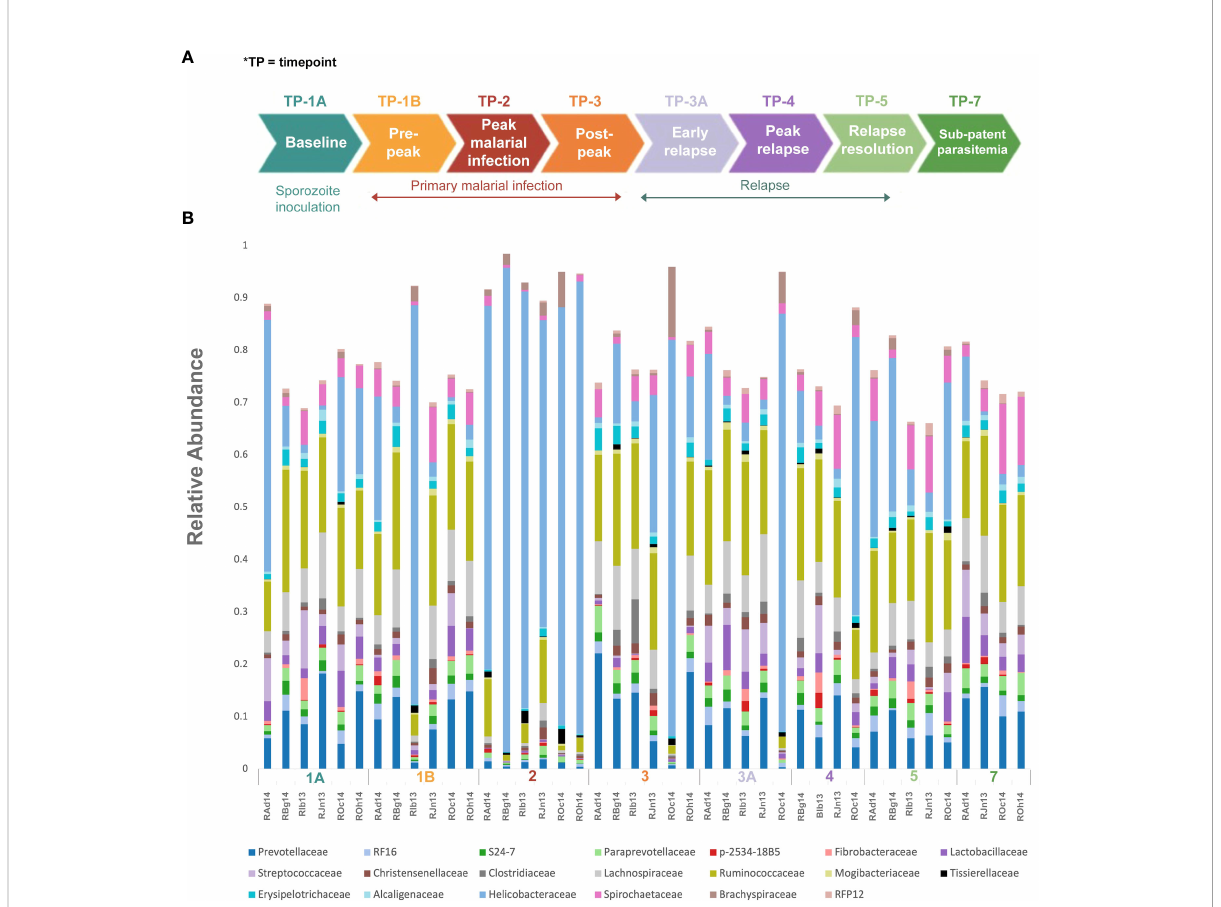
FIGURE 1 Experimental designand gut microbiota compositionof rhesus macaquesduringa longitudinal P. cynomolgi infectionstudy. (A) Experimental schematic for the longitudinal study of P. cynomolgi infection in rhesus macaques. Baseline TP1A for eachmonkey before inoculation of P. cynomolgi M/B sporozoites serves as comparisonfor the rest ofthe experiment. Patent parasitemic periodTP1Brepresents progressive increase of infected RBCs in the bloodfollowed by peak ofinfectionat TP2. Atpost-peak TP3, a decrease in hemoglobin levels, and onset of anemia may be an indicationof decreased RBC production orexcessive destructionof uninfected RBCs (hemolysis).TP3Ais a patent parasitemic periodwith increase in infected RBCs in the bloodfollowed by a progressive increase by TP4. TP5 is indicative of subpatent parasitemia with samples representative ofthe periodbetween relapses. Subpatent parasitemia at TP7 is below the microscopicthreshold. (B) Relative abundanceof predominant bacterial families in the gut of rhesusmacaques (n=6) during this longitudinal study. The referencedatabase used was